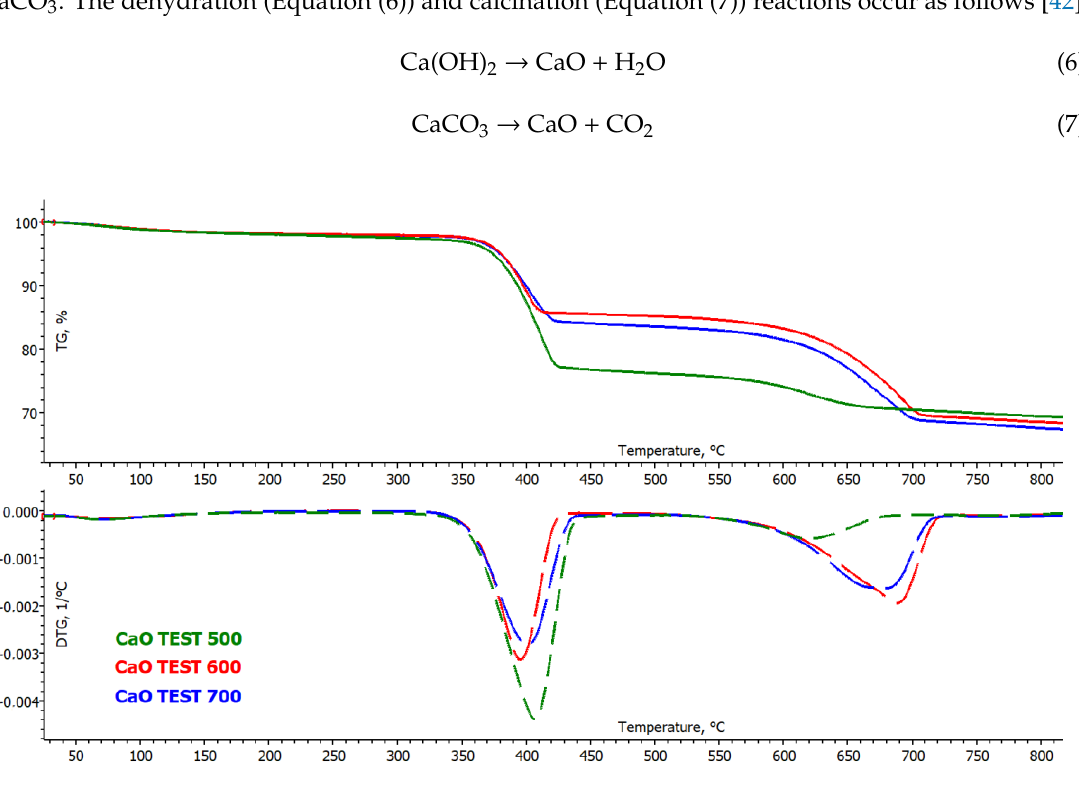
Figure 10. TG and DTG curves presenting the decomposition of CaO after CO 2 capture during the pyrolysis